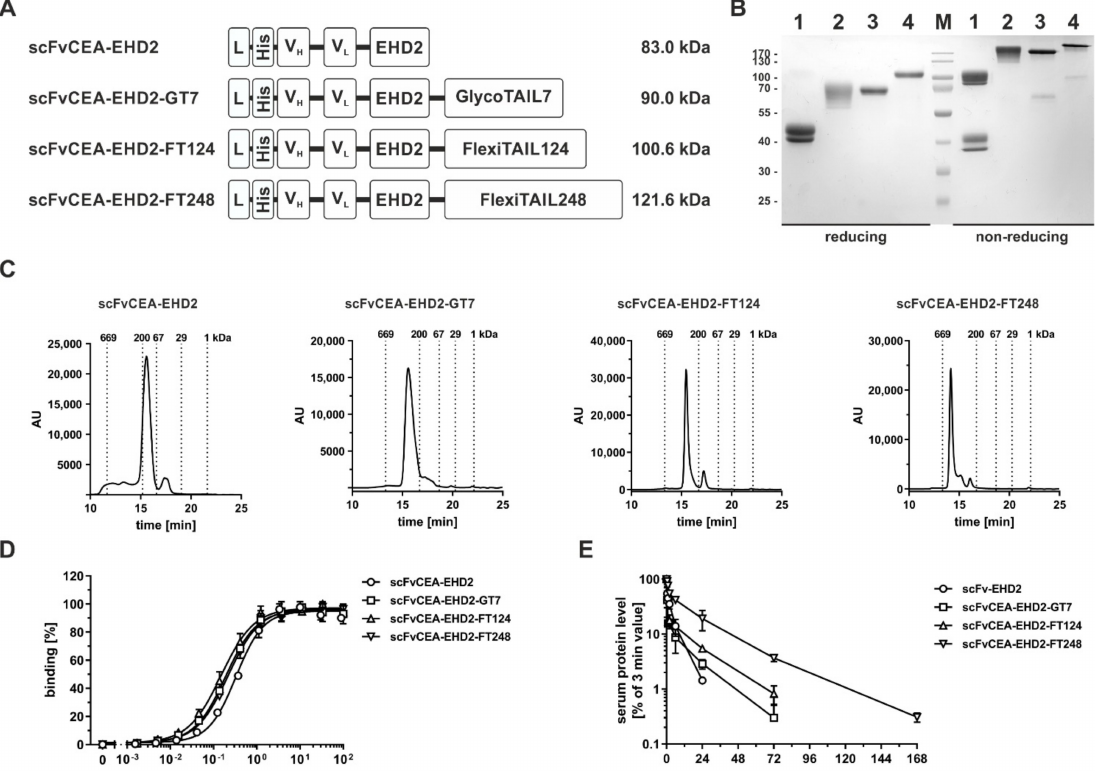
Figure 4. Analysis of scFvCEA-EHD2-based antibody molecules. ( A ) Schematic illustration of the bivalent scFvCEA-EHD2 molecules comprising C-terminal GlycoTAIL or a FlexiTAIL moiety and/or N-terminal a His-tag. ( B ) SDS-PAGE analysis of the purified scFvCEA-EHD2 molecules (1: scFvCEA-EHD2, 2: scFvCEA-EHD2-GT7, 3: scFvCEA-EHD2-FT124, 4: scFvCEA-EHD2-FT248) under reducing and non-reducing conditions in a 12% (m/v) acrylamide gel (3 µ g were loaded per lane; M: marker). ( C ) Size-exclusion chromatography of purified scFvCEA-EHD2 molecules. ( D ) Binding of different bivalent scFvCEA-EHD2 molecules to immobilized CEA in ELISA. ( E ) Phar- macokinetic analysis of different scFvCEA-EHD2 molecules, which were applied intravenously into immunocompetent CD1 mice. Protein amount of blood samples was determined via ELISA experiments. The unmodified scFvCEA-EHD2 showed significantly reduced terminal half-lives compared to the modified scFvCDEA-GT7 (*), and to both scFvCEA-EHD2-FT molecules (****), while the scFvCEA-EHD2(FT248) also showed significant differences compared to scFvCEA-EHD2-GT7 (**) and scFvCEA-EHD2-FT124 (*). In case of the drug exposure, there was also a significant difference between the scFvCEA-EHD2 molecule compared to all other modified molecules (****). Mean ± SD, n =